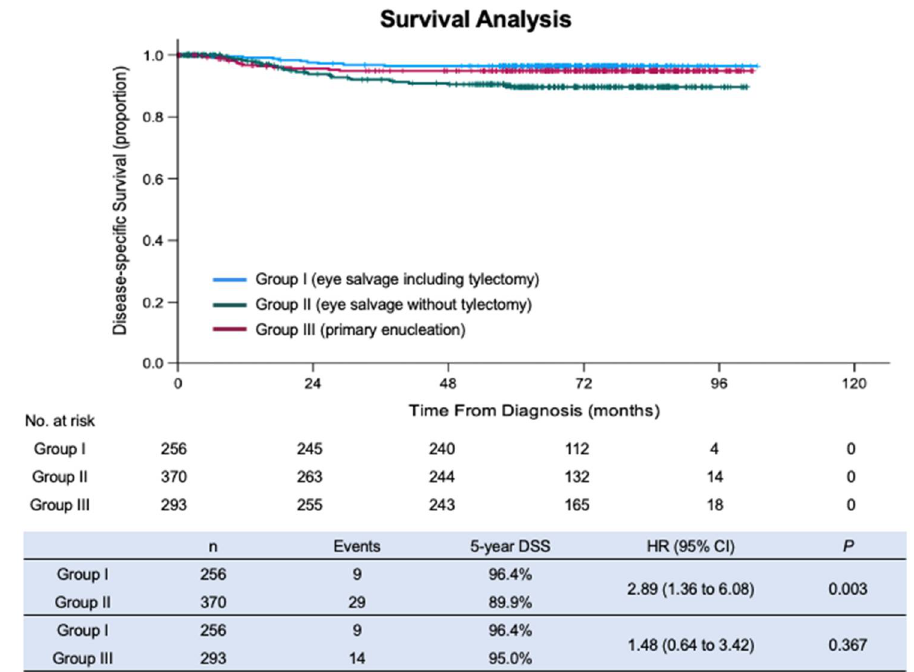
Figure 3. Kaplan–Meier curves of disease-specific survival (DSS) of patients from Group I, II, and III.